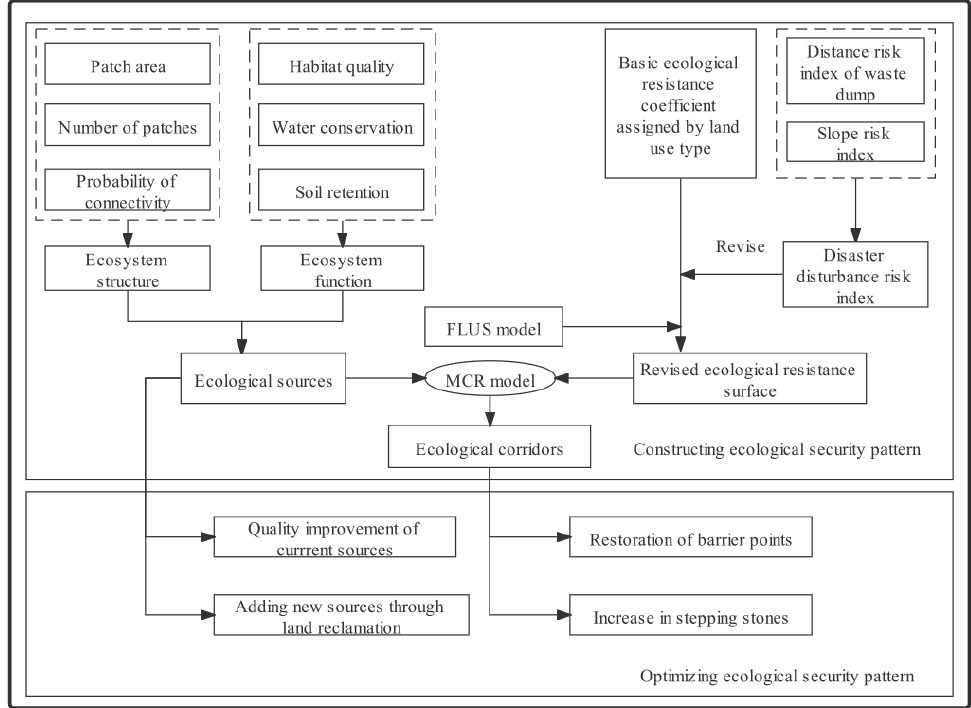
Figure 2. Methodological framework used to construct and optimize ESP.